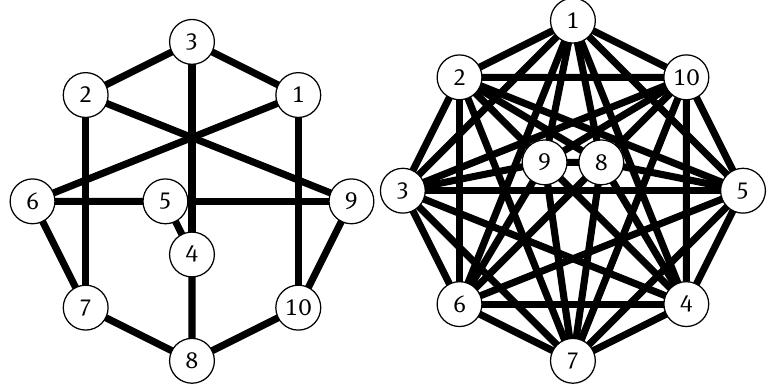
Figure 8: F 1 and F 2 , D L cospectral graphs with different girth, Weiner indexes, k -regularity, and k -transmission regularity and are only M -cospectral for M = D